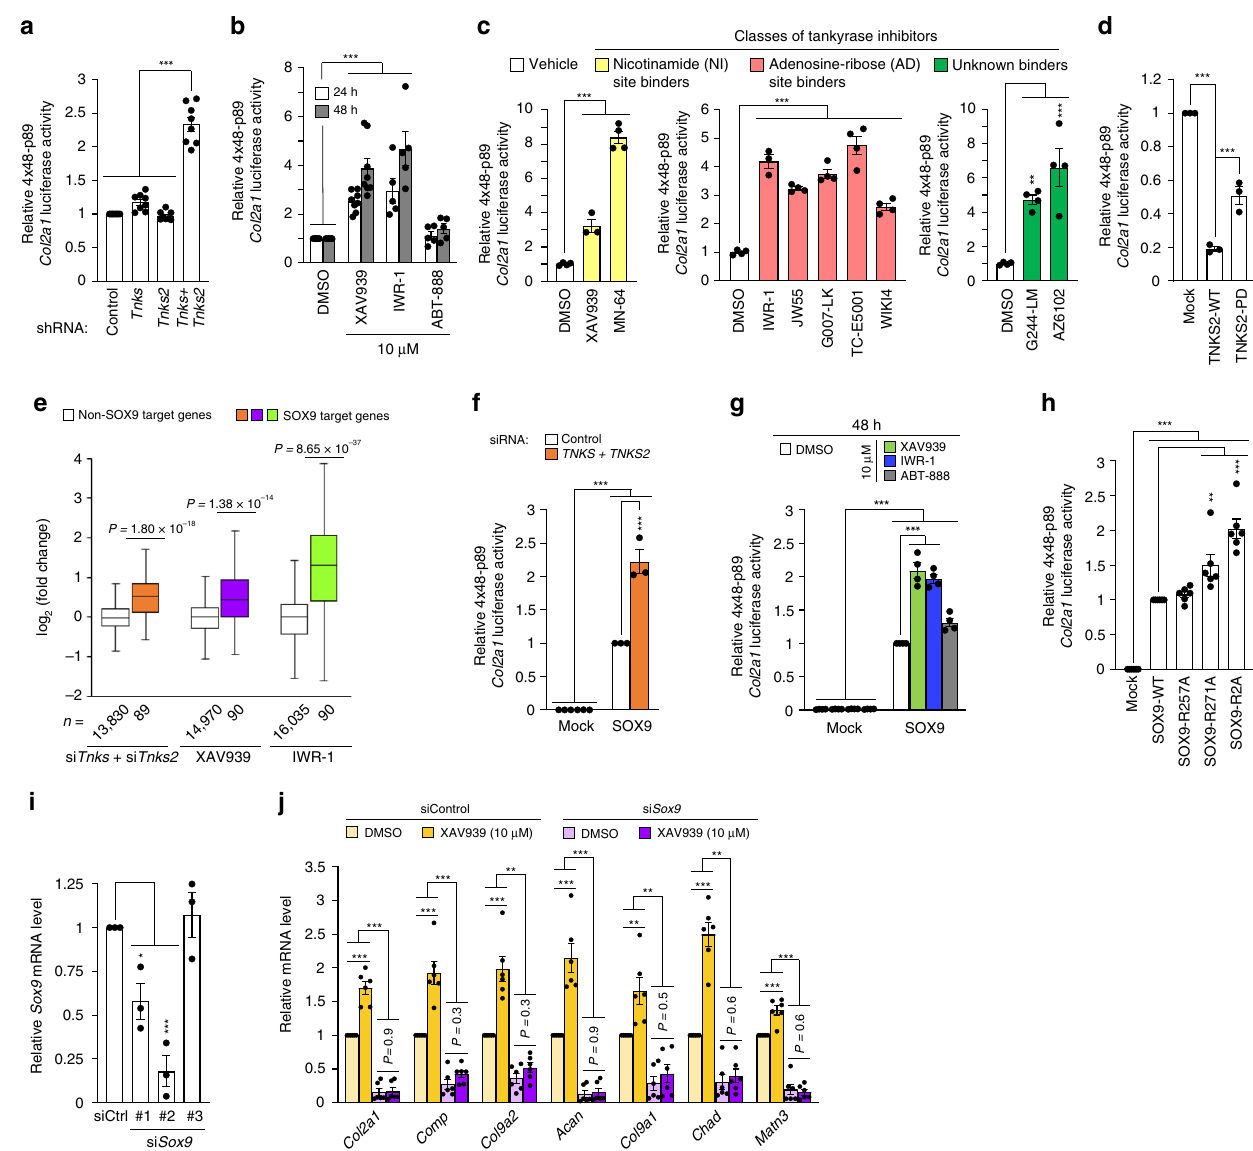
Fig. 5 Tankyrase inhibition enhances cartilage matrix gene expression in a SOX9-dependent manner. a – c A 4 × 48-p89 SOX9-dependent Col2a1 luciferase reporter assay in chondrocytes treated with a control shRNA, sh Tnks , sh Tnks2 , or sh Tnks and sh Tnks2 ( n = 8), b XAV939, IWR-1, or PARP1/2 inhibitor ABT- 888 ( n ≥ 5), or c 10 μ M of various tankyrase inhibitors for 48 h ( n ≥ 3). b , c DMSO was used as a negative control. d A 4 × 48-p89 SOX9-dependent Col2a1 luciferase reporter assay in chondrocytes transfected with control mock vector, wild-type TNKS2 vector, or PARP-dead (PD) TNKS2 mutant vector ( n = 3). e Box plot of fold changes of SOX9 target genes and other genes (two-tailed t test) in chondrocytes. The box represents data from 25 to 75% percentile. The center line in the box represents median, and whiskers extend 1.5 times the interquartile range from the box edges. SOX9 target genes are listed in Supplementary Table 8. f , g A 4 × 48-p89 SOX9-dependent Col2a1 luciferase reporter assay in HEK293T cells transfected with mock vector or CMV-driven SOX9- expression vector and treated with f si TNKS and si TNKS2 ( n = 3) or g DMSO, XAV939, IWR-1, or ABT-888 ( n = 4). h A 4 × 48-p89 SOX9- dependent Col2a1 luciferase reporter assay in HEK293T cells expressing wild-type SOX9 or SOX9 with tankyrase-binding motif point mutation ( n = 6). SOX9 R2A mutant has both R257A and R271A mutations. i Knockdown ef fi ciency of various Sox9 siRNAs in primary cultured mouse chondrocytes ( n = 3). si Sox9 #2 was used throughout this study. j mRNA levels of cartilage-speci fi c matrix genes in mouse chondrocytes transfected with control siRNA or si Sox9 #2 followed by DMSO or XAV939 treatment for 72 h ( n = 6). a – d , f – j Data represent means ± s.e.m. * P < 0.05, ** P < 0.01, *** P < 0.001 by